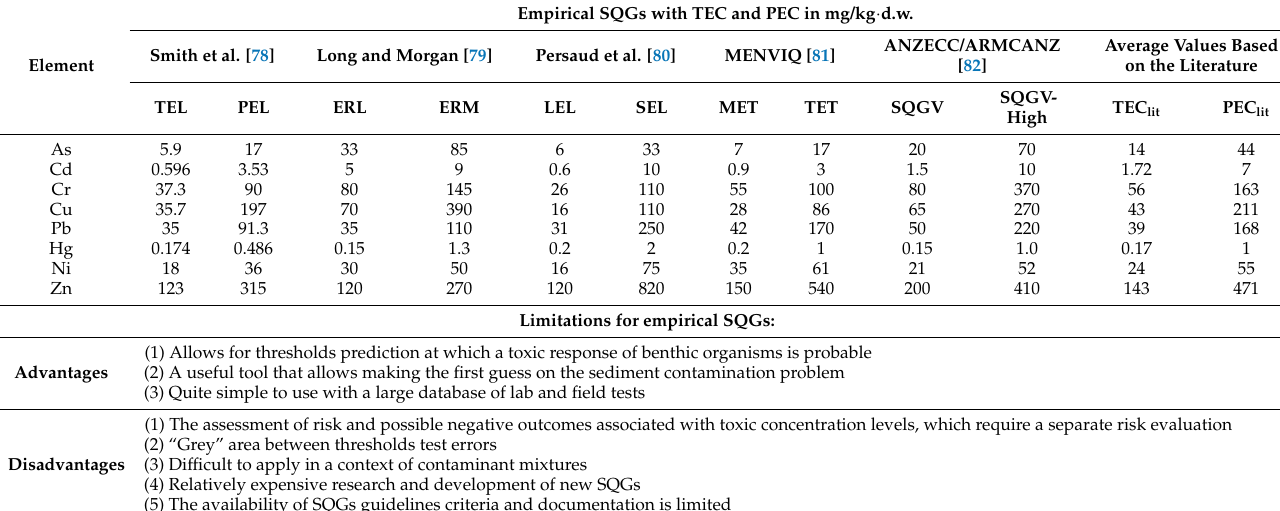
Table 2. Sediment quality guidelines (SEQs) for TMs and metalloid in mg/kg d.w. that reflect threshold effect concentration (TEC) and probable effect concentration (PEC) [77–82]. Empirical SQGs with TEC and PEC in mg/kg · Element